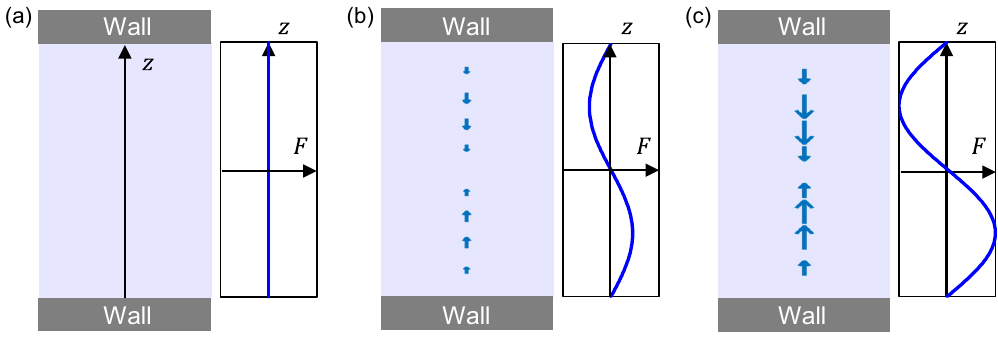
Figure 3. Left panels: cross-section sketches of a straight, hard-walled water-filled channel. The acoustic radiation force is illustrated by blue arrows at time ( a ) t = 2 s, ( b ) 3.2 s, and ( c ) 4 s. Right panels: transverse and standing ultrasound wave in the channel.